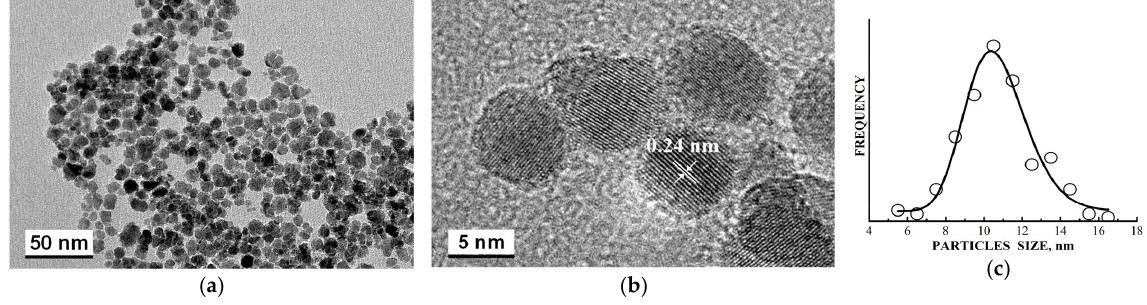
Figure 41. TEM and HRTEM images of FM as‑prepared γ ‑Fe 2 O 3 nanoparticles ( a , b ) and particle size distribution ( c ). Adapted from Ref. [76] with permission from Springer Nature: Hyperfine